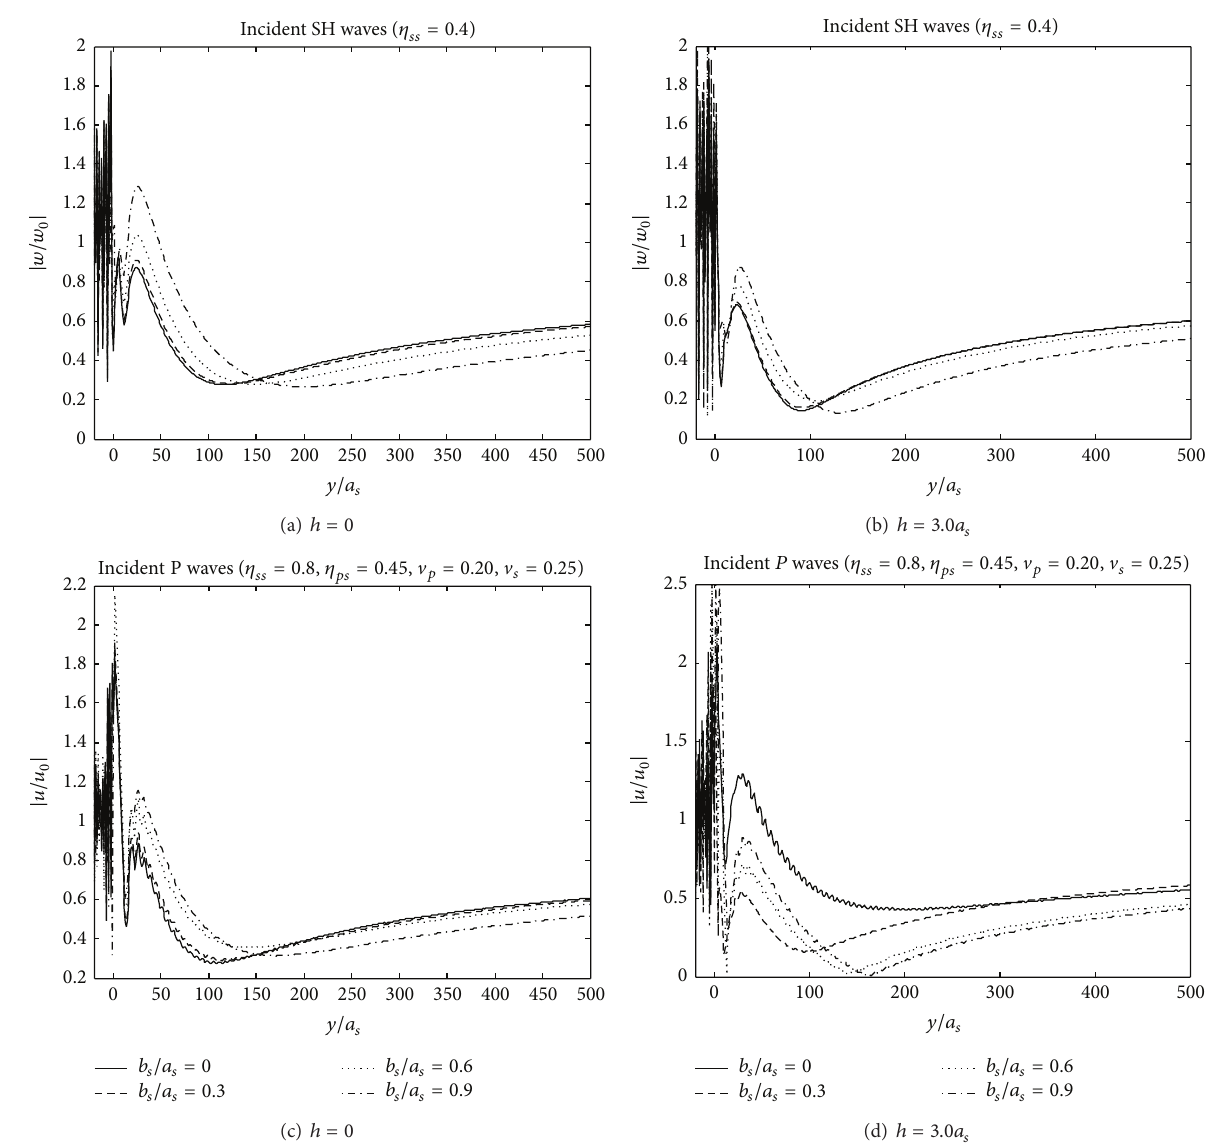
Figure 5: Normalized displacement amplitudes curves along midline behind the isolation system under different ratios of internal and external diameters of tubular piles ( 𝐺 𝑟 = 100 , 𝑠 𝑝 = 3.0𝑎 𝑠 , 𝑚 = 4 , 𝑁 = 8 ).